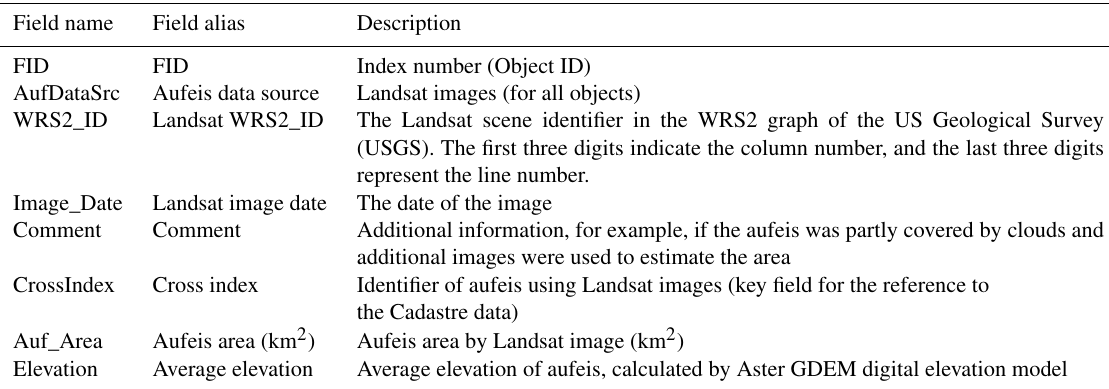
Table 2. The structure of the GIS database of aufeis using Landsat images